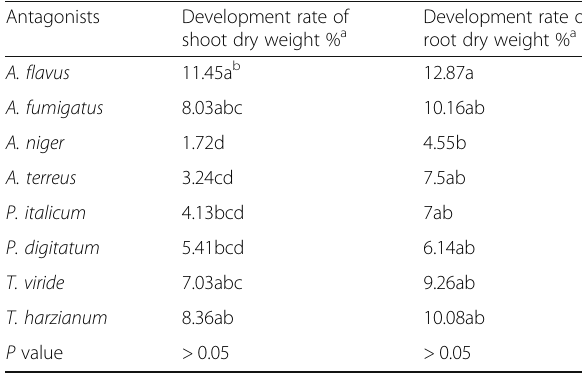
Table 6 Beneficial effect of four Aspergillus spp. isolates, two Penicillium spp. isolates, and two Trichoderma spp. isolates on melon plants in vivo assay, revealed by development rate